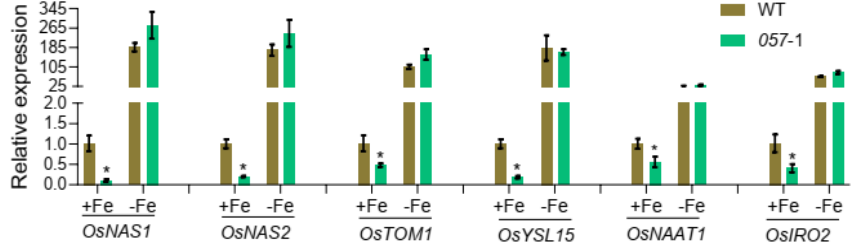
repressed compared with the WT under Fe-sufficient conditions (Figure 5). The rice bHLH protein OsIRO2 is a vital regulator of Fe homeostasis that controls the expression of OsNAS1 , OsNAS2 , TOM1 , OsYSL15 , and OsNATT1 . Therefore, we quantified the expression level of OsIRO2 in the WT and osbhlh057 - 1 . Similar to OsNAS1 , OsNAS2 , TOM1 , OsYSL15 , and OsNATT1 , the OsIRO2 expression level in osbhlh057 - 1 was lower than in the WT under Fe-sufficient conditions but identical to the WT under Fe-deficient conditions (Figure 5).